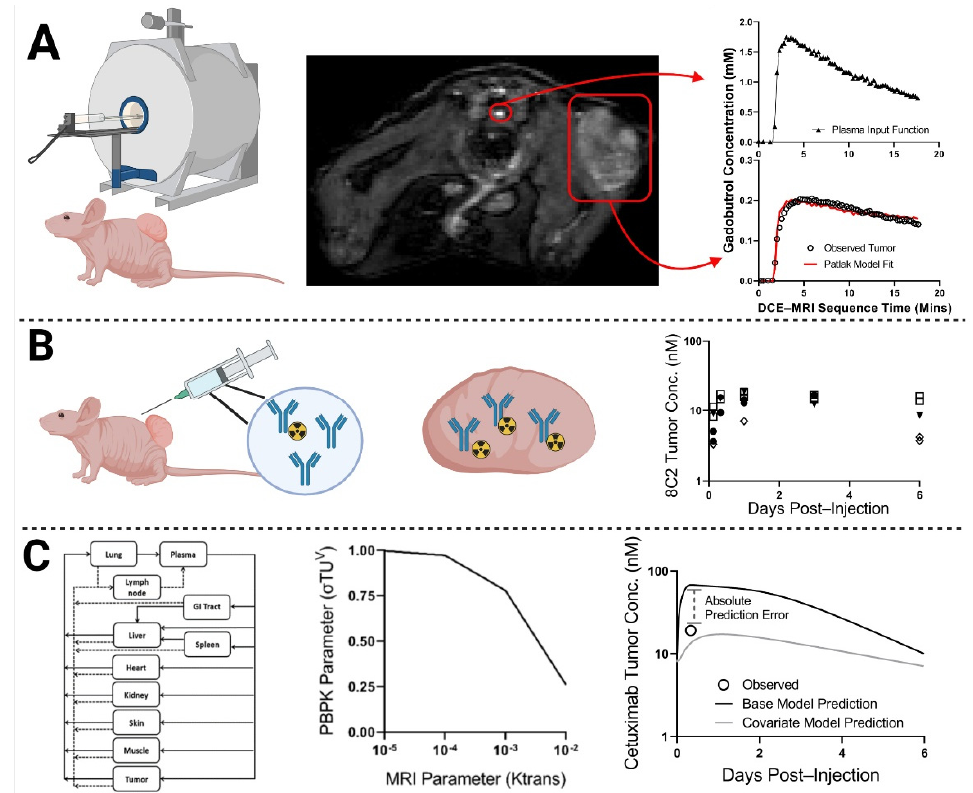
Figure 2. Workflow Diagram: In step ( A ), xenograft-bearing mice underwent DCE-MRI. Images were analyzed to obtain Patlak pharmacokinetic model fits for each xenograft bearing mouse, using individual plasma input functions. In step ( B ), one day post-MRI, the same xenograft-bearing mice were administered the non-tumor binding antibody 8C2 with a tracer dose of 125 I-8C2 (depicted as a blue Y with a radioactive symbol). Following tumor resection, 8C2 tumor concentrations were determined via gamma counting at a single terminal timepoint per mouse (timepoints ranged from 3 h to 6 days). In step ( C ), relationships were drawn through PBPK modeling between the observed quantitative MRI parameter values for each tumor (obtained in step ( A )) and the corresponding observed value for 8C2 tumor concentration (obtained in step ( B )). The middle image for step C represents a potential relationship between the MRI parameter K trans and the PBPK parameter that represents tumor vascular permeability ( σ TUV ). A PBPK model that implemented the MRI-PBPK relationship shown in step ( C ) would predict less tumor uptake (due to a higher reflection coefficient) for a xenograft with an observed K trans value of 10 − 5 min − 1 in comparison to a tumor with a higher observed K trans value of 10 − 2 min − 1 . A second round of MRI imaging is then performed for xenograft- bearing mice that are administered cetuximab (repeating steps ( A , B )). Cetuximab tumor uptake is predicted a priori for individual xenografts based on their observed DCE-MRI parameter values using the MRI-PBPK relationships that were established in step ( C ). Model prediction accuracy for the MRI-PBPK covariate model was compared to the predictions that were made using the base PBPK model without consideration of the MRI-PBPK relationship. Created with BioRender.com (accessed on 23 Novermber